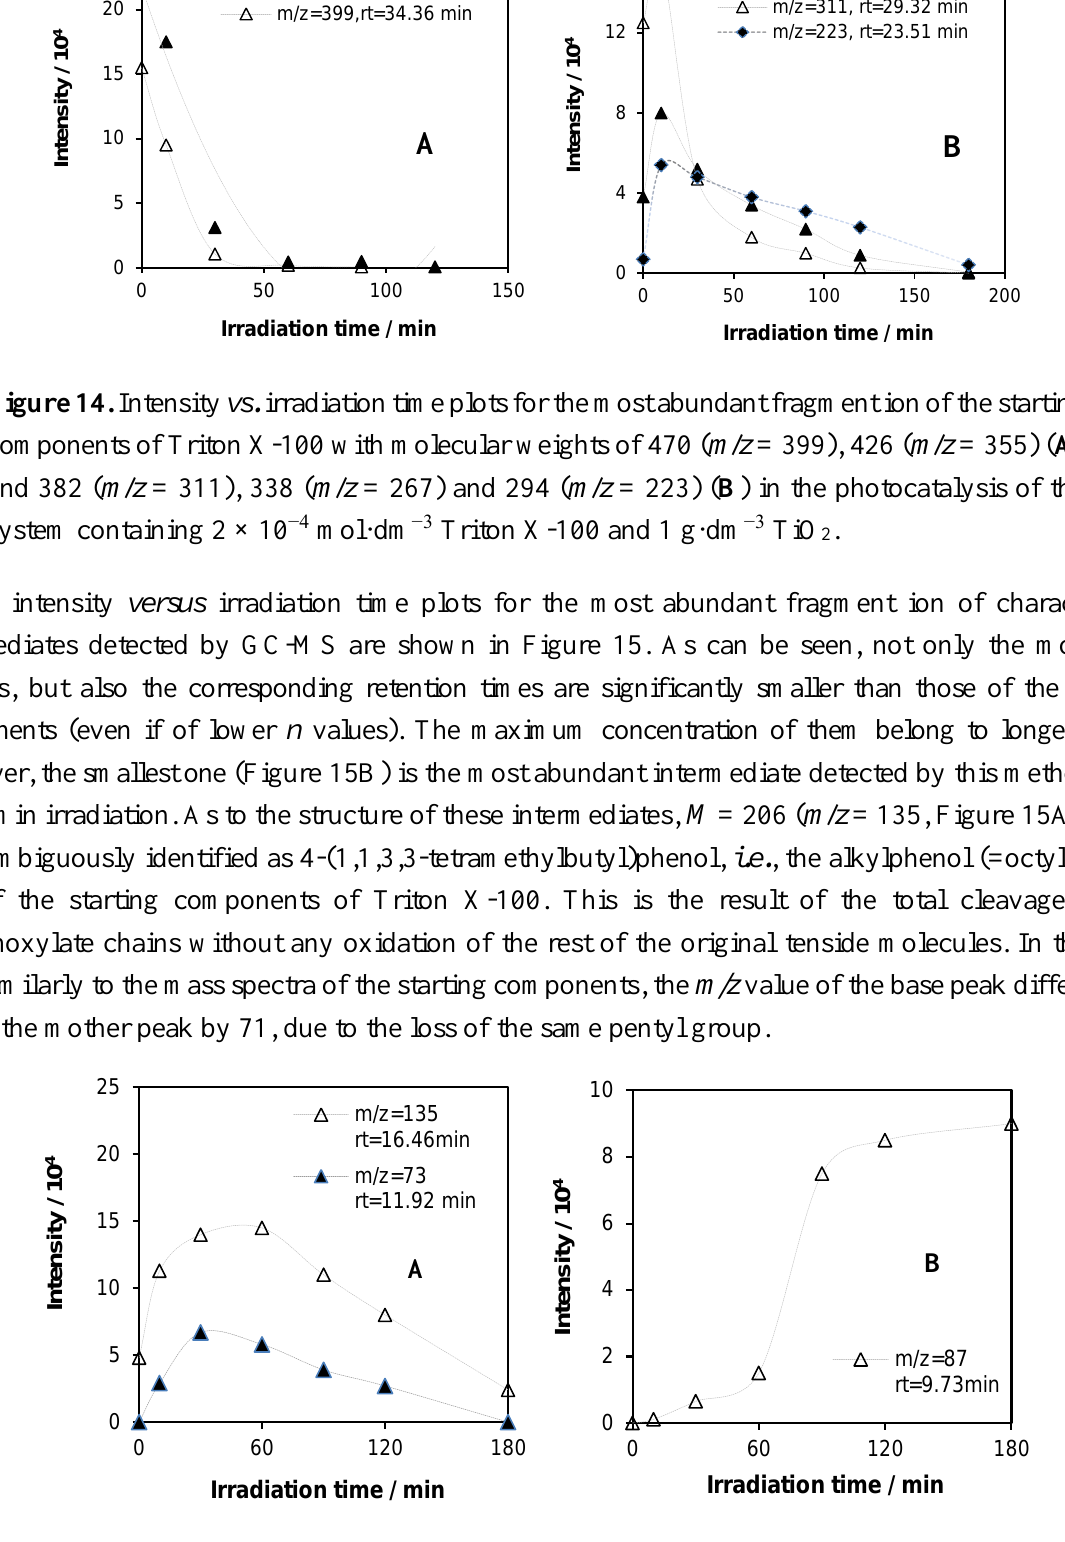
Figure 15. Intensity vs. irradiation time plots for the most abundant fragment ion of characteristic intermediates with molecular weights of 206 ( m / z = 135), 148 ( m / z = 73) ( A ) and 118 ( m / z = 87) ( B ) in the photocatalysis of the system containing 2 × 10 −4 mol·dm −3 Triton X-100 and 1 g·dm −3 TiO 2